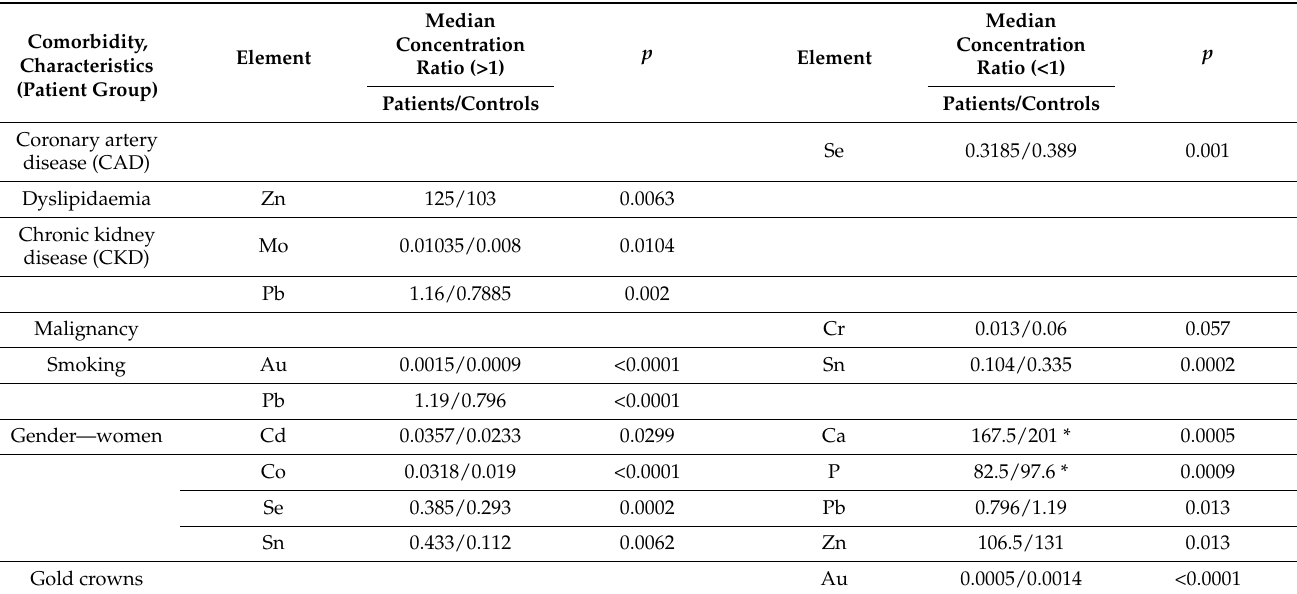
Table 3. Median concentration ratios of metals and trace elements in aortic valves of patients and controls in selected comorbidities and